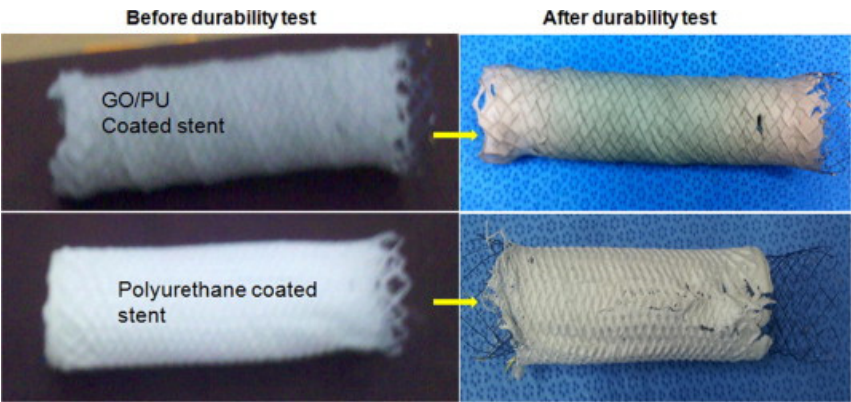
Figure 3. Caption of polyurethane and graphene-oxide-based polyurethane (GO/PU) membrane before and after the coated stent durability test, as reported by Pant et al. [125]